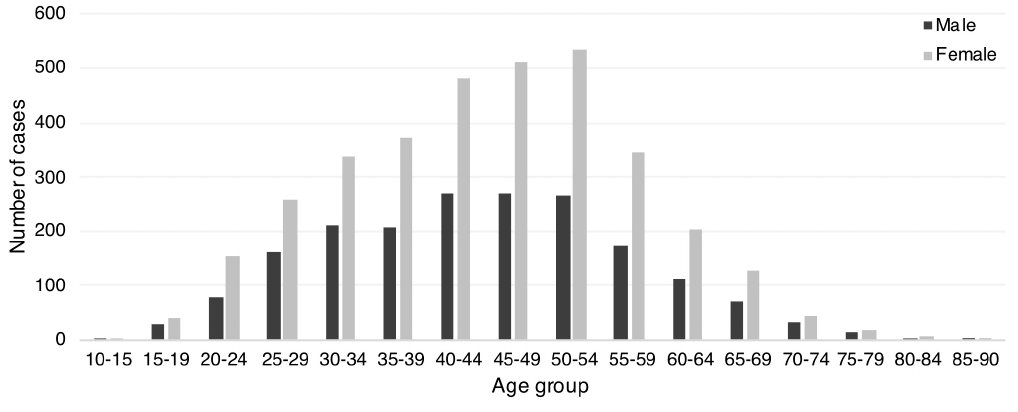
Figure 2. Prevalence of multiple sclerosis (MS) by age and sex.